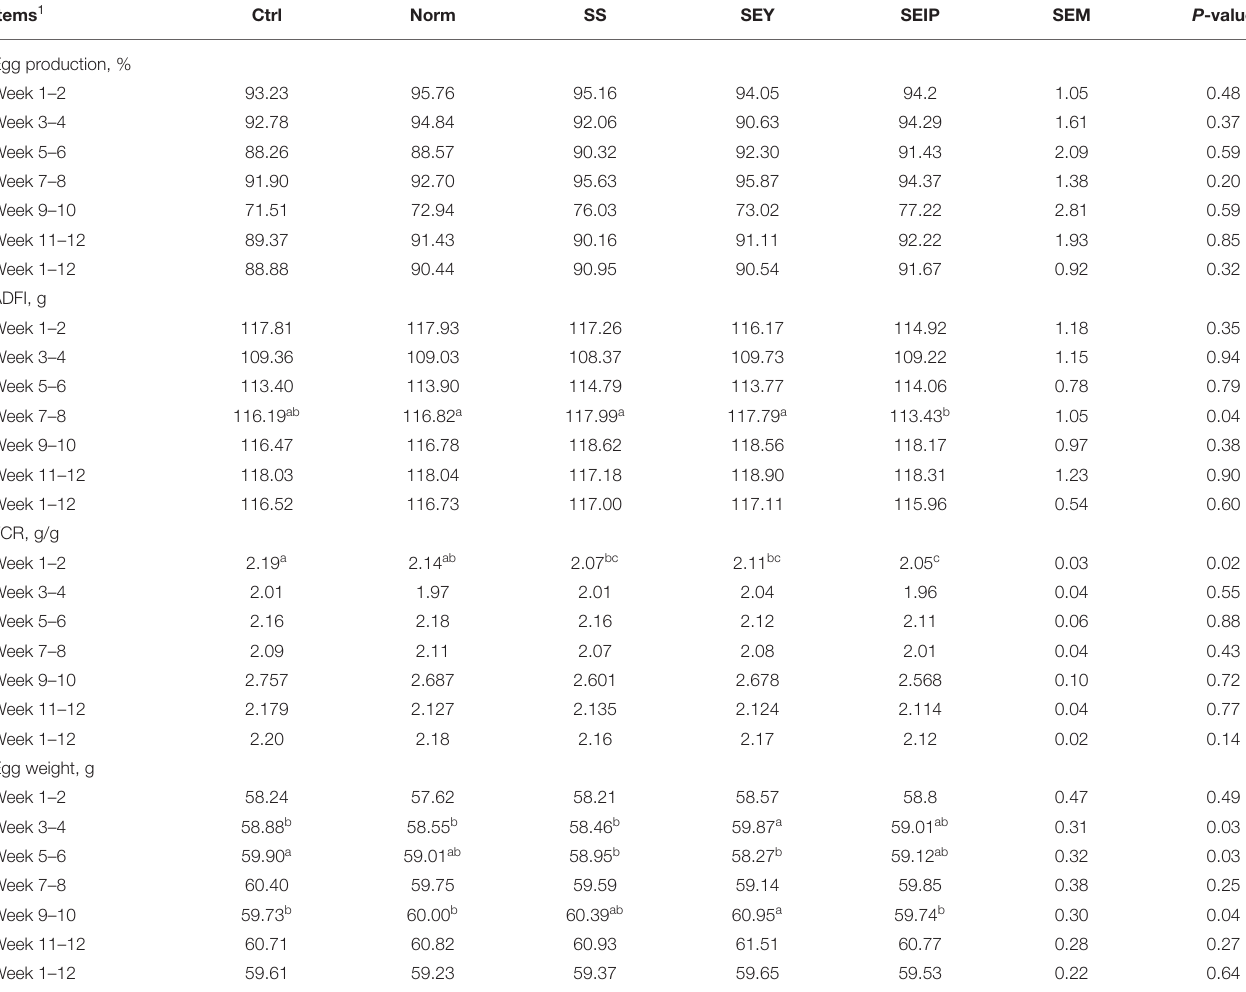
TABLE 2 | Effects of dietary Se sources on performance of laying